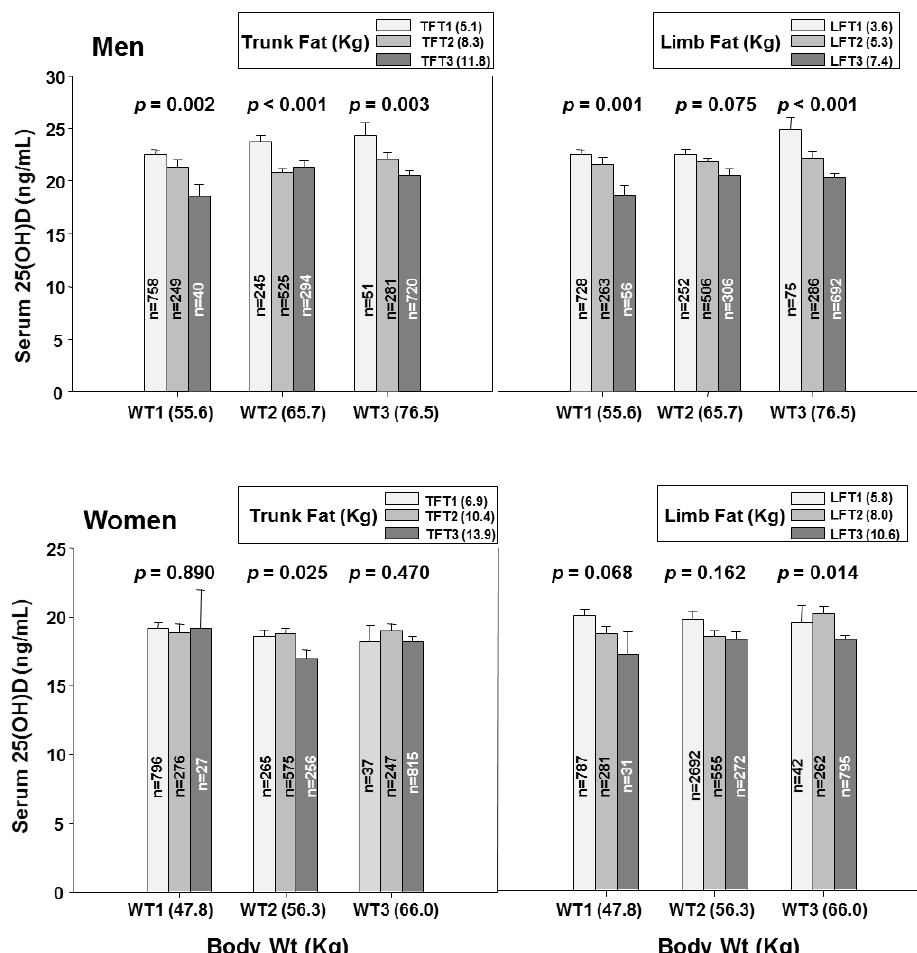
Figure 4. Serum 25-hydroxyvitamin D concentrations by trunk fat and limb fat tertiles within each body weight tertile categories. 25(OH), 25-hydroxyvitamin D; WT1, the first tertile of body weight (55.6 Kg, 31.9–61.6 Kg for men and 47.9 Kg, 32.3–52.7 Kg for women); WT2, the second tertile of body weight (65.7 Kg, 61.7–69.8 Kg for men and 56.3 Kg, 52.8–59.8 Kg for women); WT3, the third tertile of body weight (76.5 Kg, 69.9–108.6 Kg for men and 66.0 Kg, 59.9–100.0 Kg for women); Bar plots in each body weight tertile categories represent tertiles of trunk fat mass (TFT1, the first tertile of trunk fat mass, 5.1 Kg, 1.3–6.9 Kg for men and 6.9 Kg, 1.9–8.9 Kg for women; TFT2, the second tertile of trunk fat mass, 8.3 Kg, 6.9–9.6 Kg for men and 10.4 Kg, 9.0–11.6 Kg for women; TFT3, the third tertile of